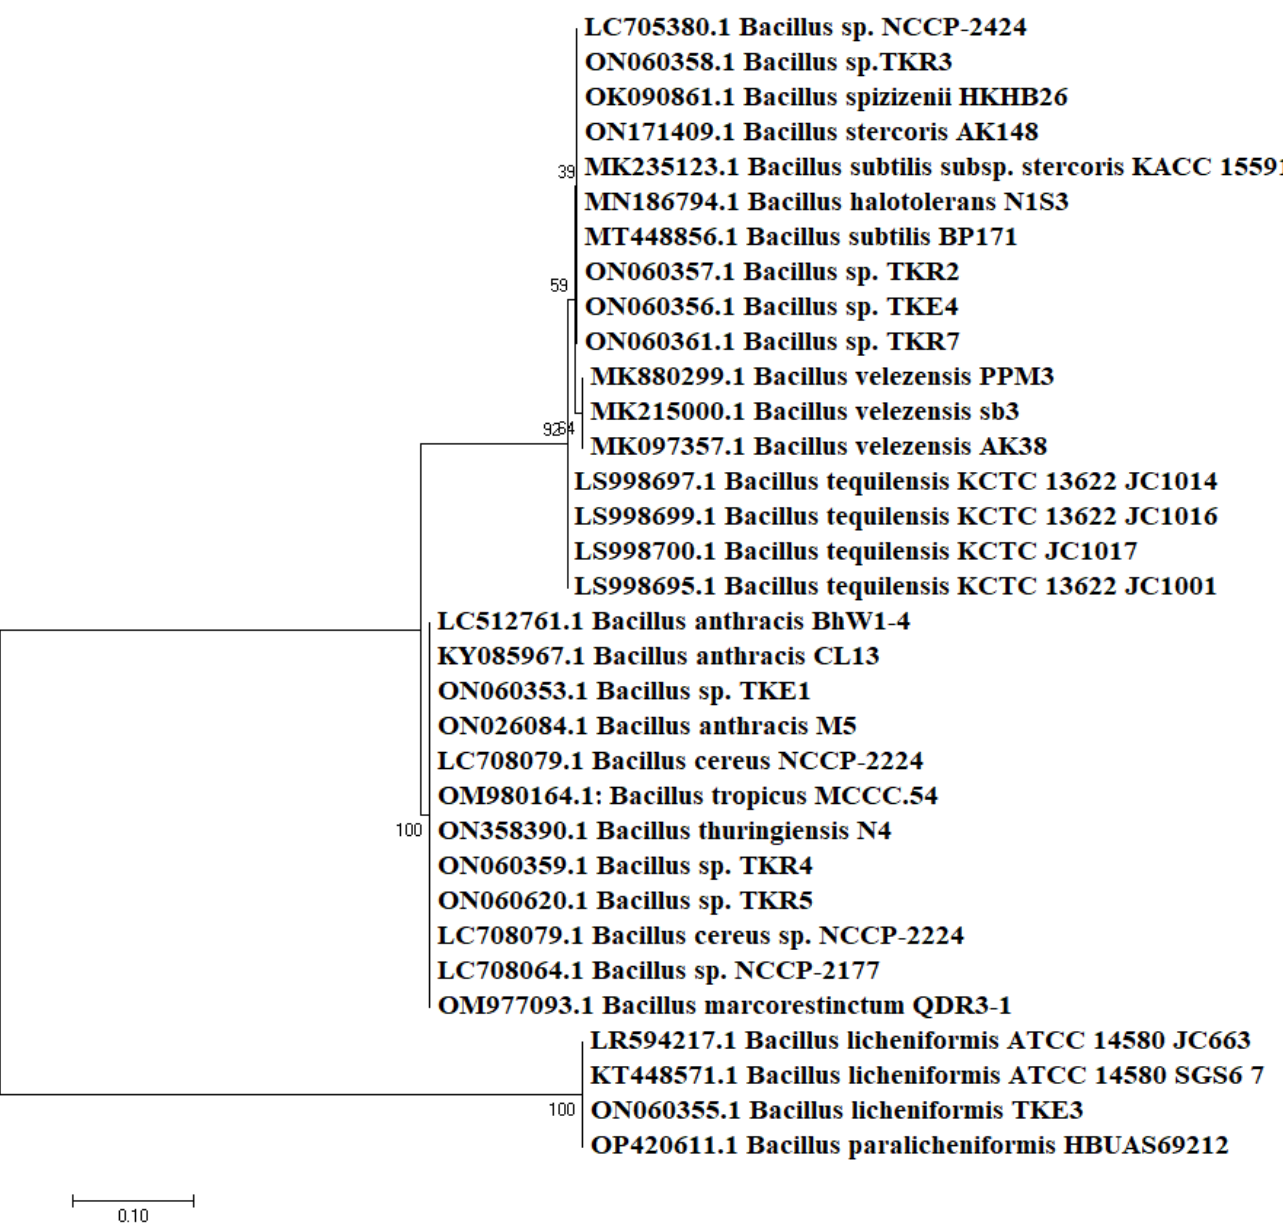
Figure 3. Phylogenetic tree reconstruction of the Bacillus species by maximum likelihood method using 1000 bootstrap replications.